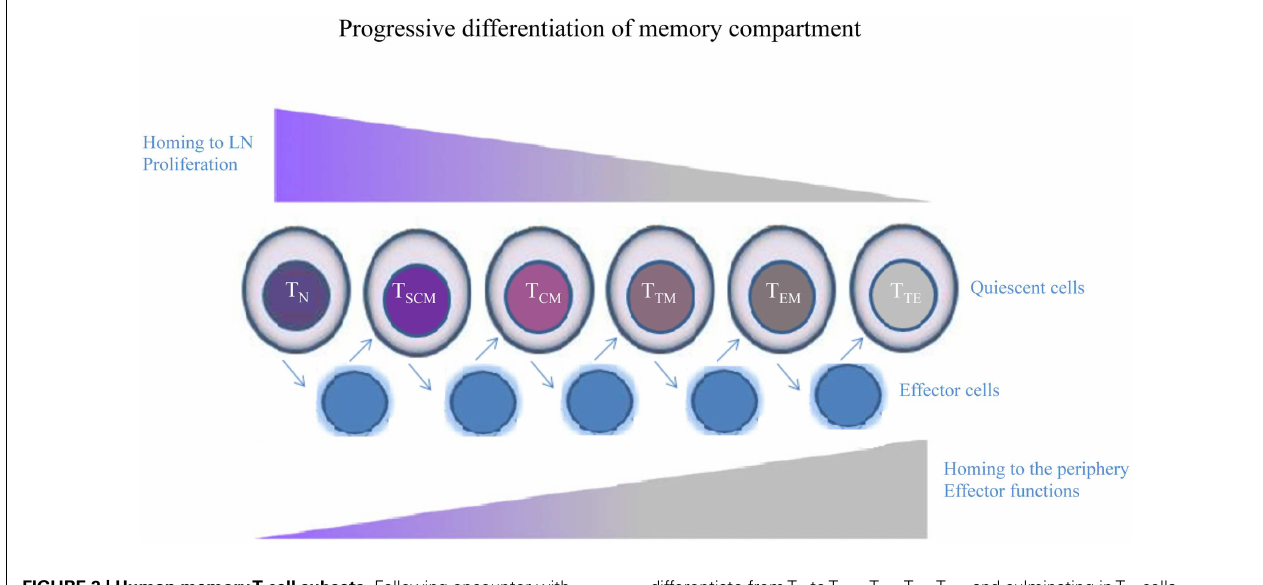
FIGURE 2 | Human memoryT cell subsets . Following encounter with Ag, quiescentT cells develop into effectors, whose phenotype is highly dynamic and largely unpredictable.When the Ag is cleared, effectorT cells that survive return to a quiescent memory state. Cells